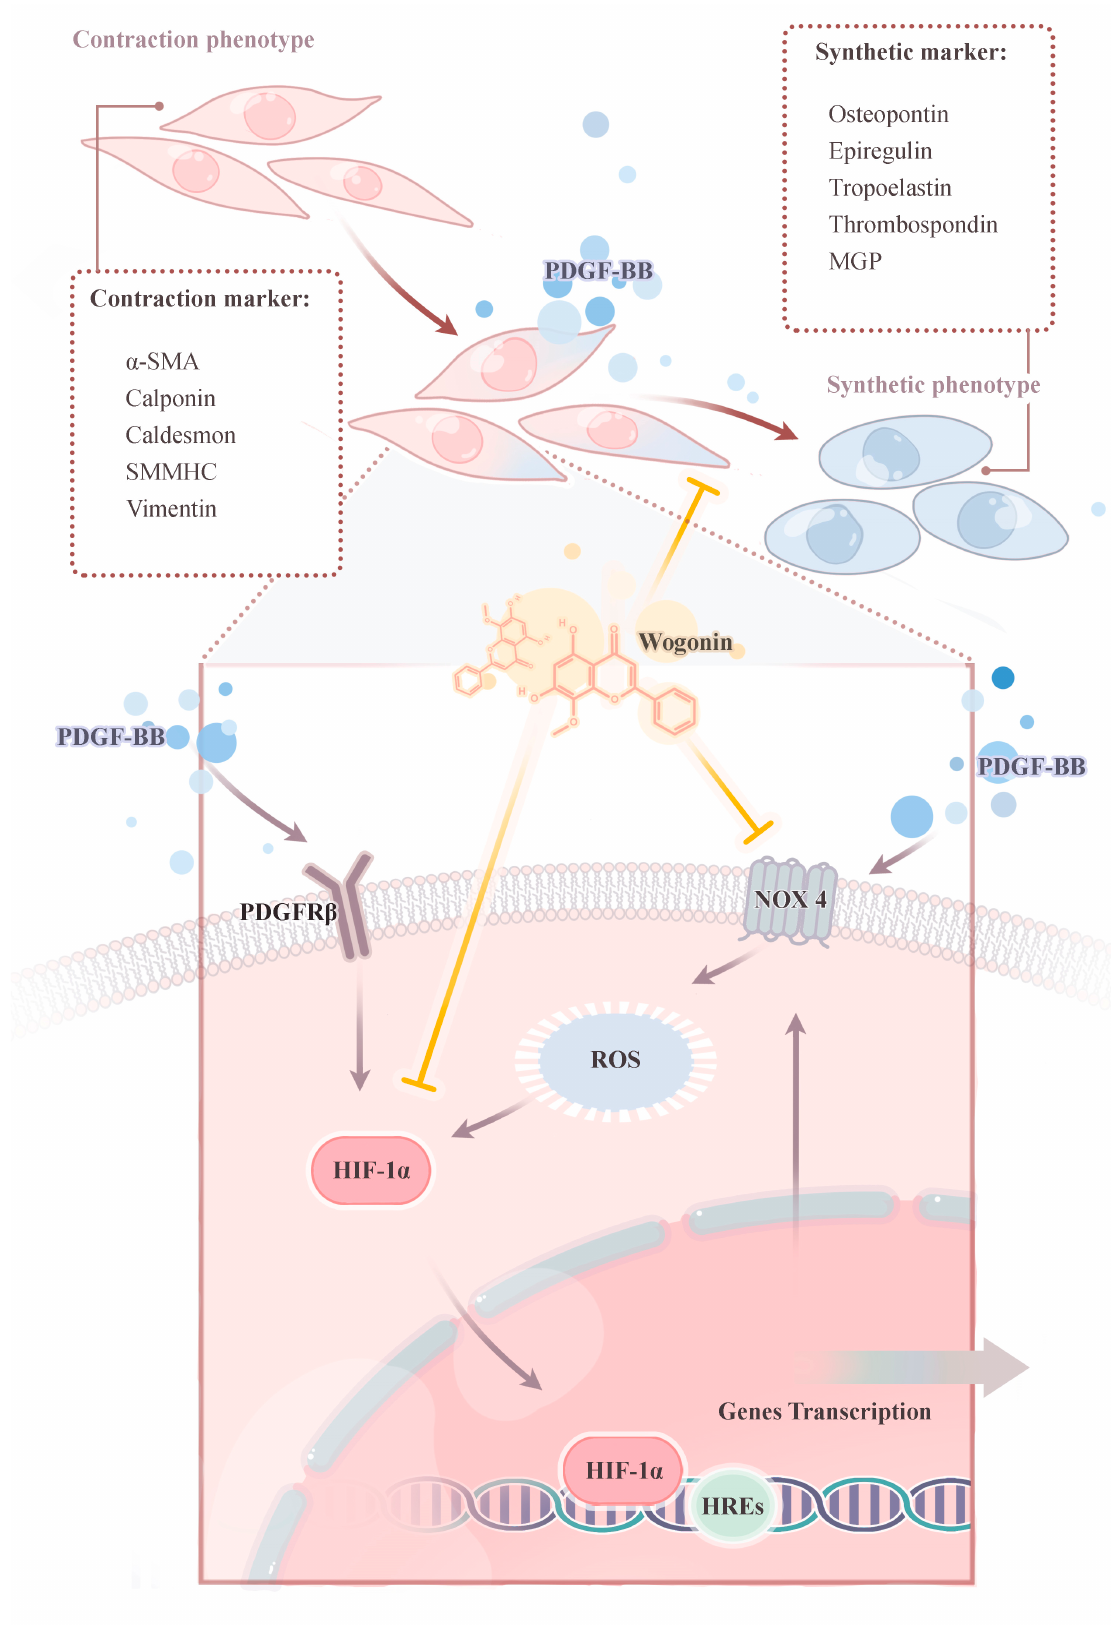
Figure 10. Schematic drawing showing the mechanisms of the anti-proliferative effects on PDGF-BB- induced proliferation of